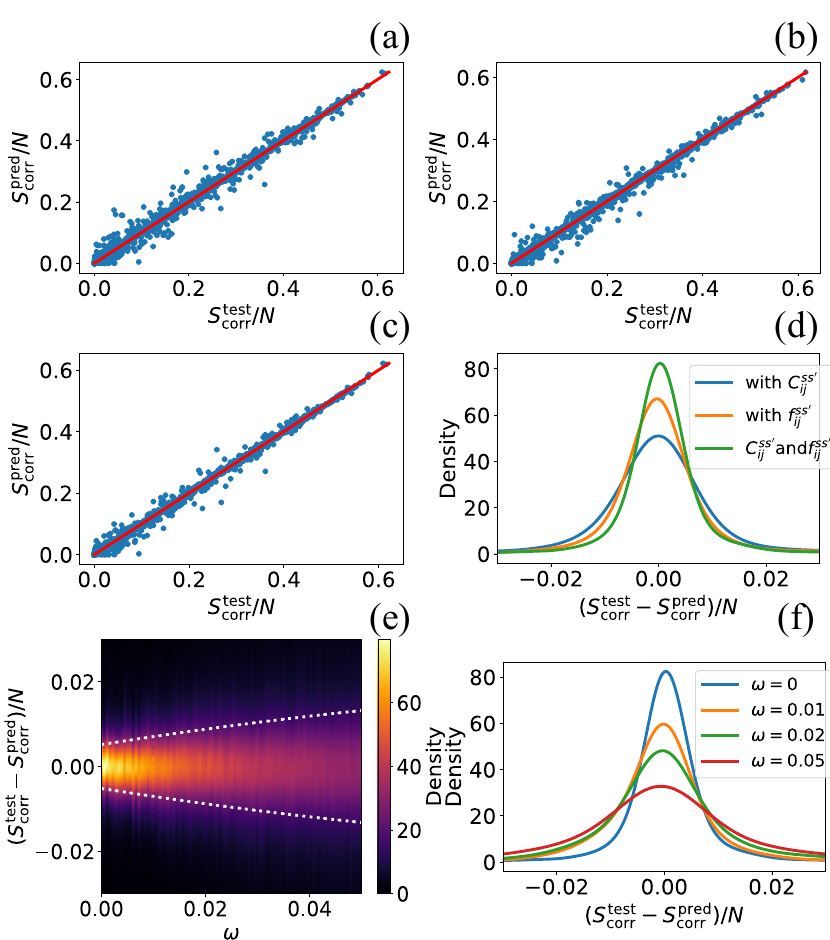
Figure 3: Predictions of the neural-network algorithm on the generalized interacting model in Eq. (3). (a) Predictions of the model trained with particle-particle correla- ′ ′ tors C ss . (b) Predictions of the model trained with density-density correlators f ss . ij ij ′ ′ (c) Predictions of the model trained on both C ss and f ss . (d) Probability distribu- ij ij tion of the difference between the predicted entropy from local measurements and − S pred the true one S test in (a,b,c). (e) Probability distribution of the error in the corr corr prediction in the presence of noise. The half-band width of the probability distribu- tion is depicted as a white dotted curve. (f) Probability distribution of the error in the prediction for particular noise